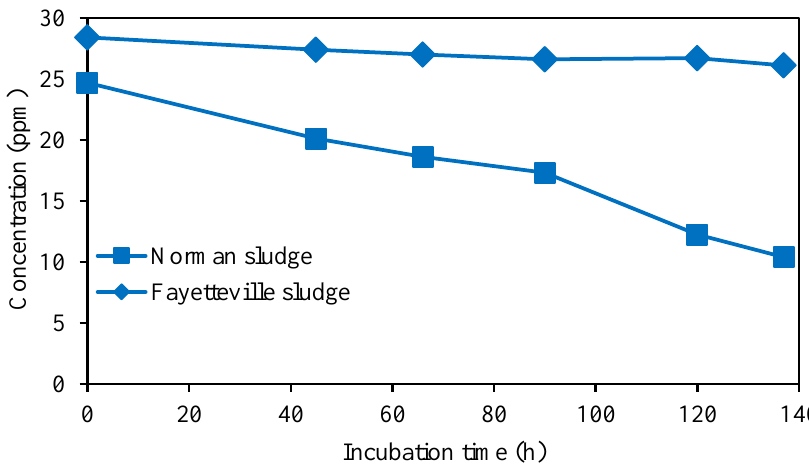
Figure 9. Decrease in atrazine concentration in Bushnell Hass broth as a function of time for Fayetteville and Norman sludges under aerobic conditions.